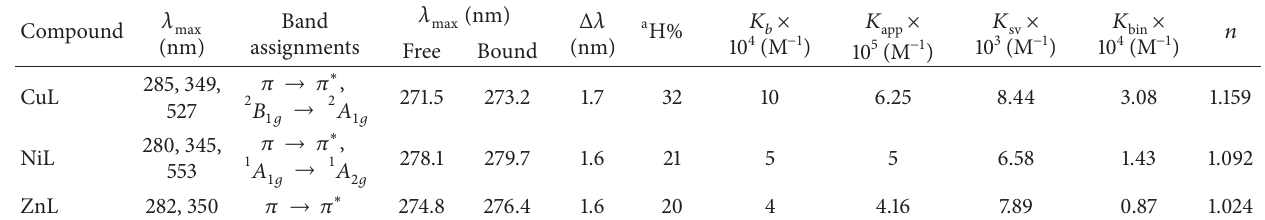
Figure 1: 13 C NMR spectrum of ZnL recorded in DMSO-d 6 . Table 1: Absorption and emission spectral properties of metal (II) complexes with CT